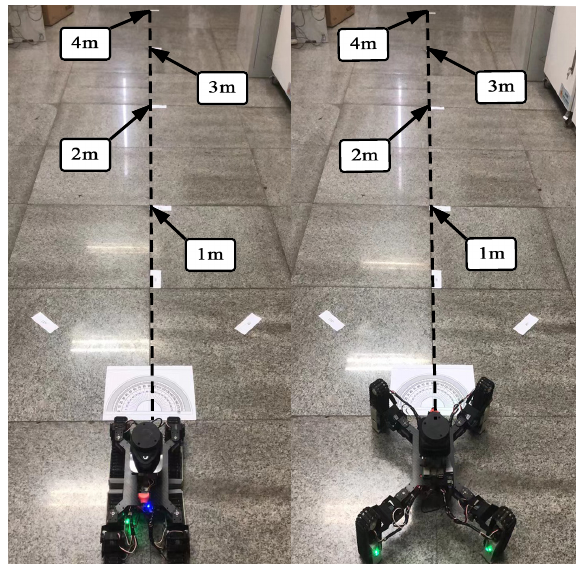
Figure 14. The moving straight experiment in tracked and legged